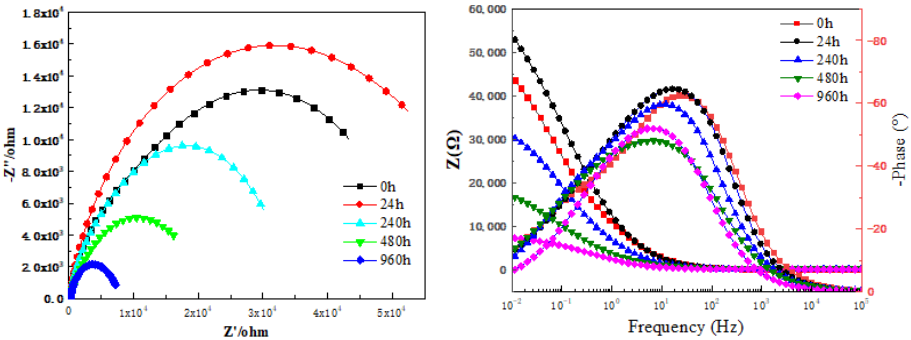
Figure 4. Results of electrochemical impedance spectroscopy of copper immersed in formic acid solution for different time.